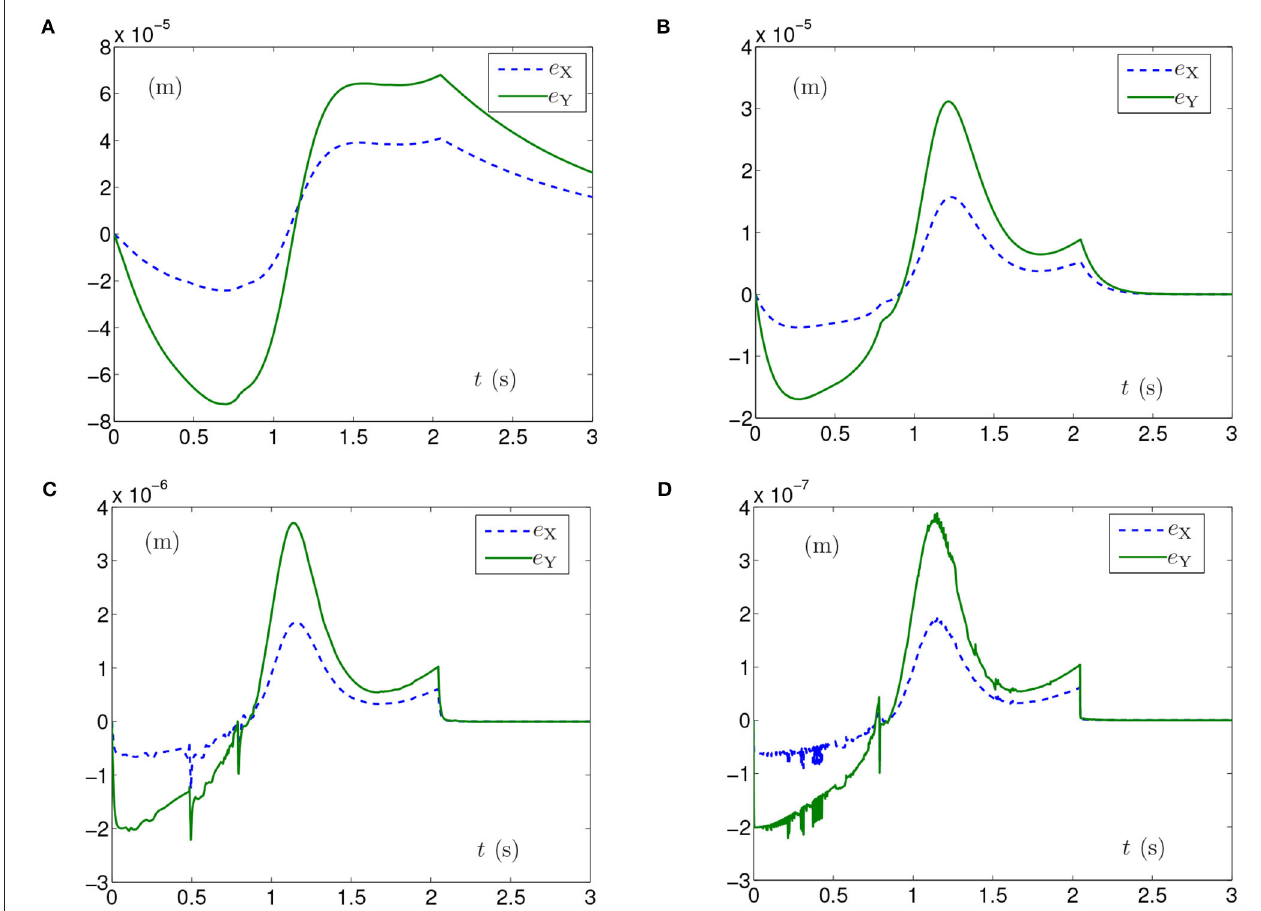
FIGURE 7 | End-effector position errors of planar manipulator using SMCSvZ with time-varying physical limits verged in Case B. (A) With µ 2 = 1. (B) With µ 2 = 10. (C) With µ 2 = 100. (D) With µ 2 =